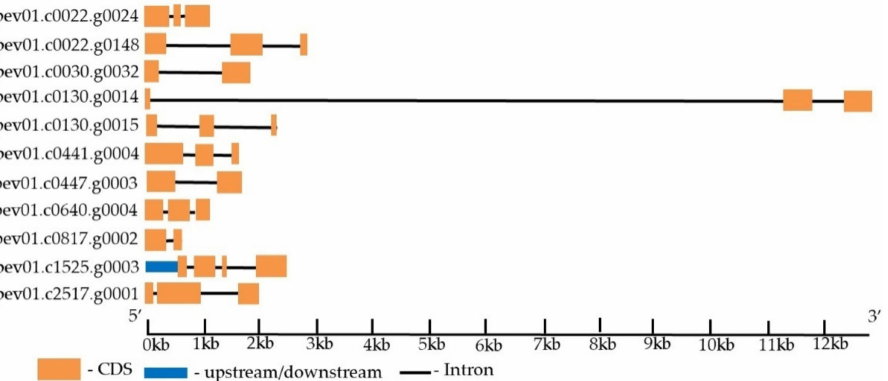
Figure 7. The structure of the B. pendula WOX genes. The intron, exon, and untranslated region (UTR) are represented by black lines, orange boxes, and blue boxes,